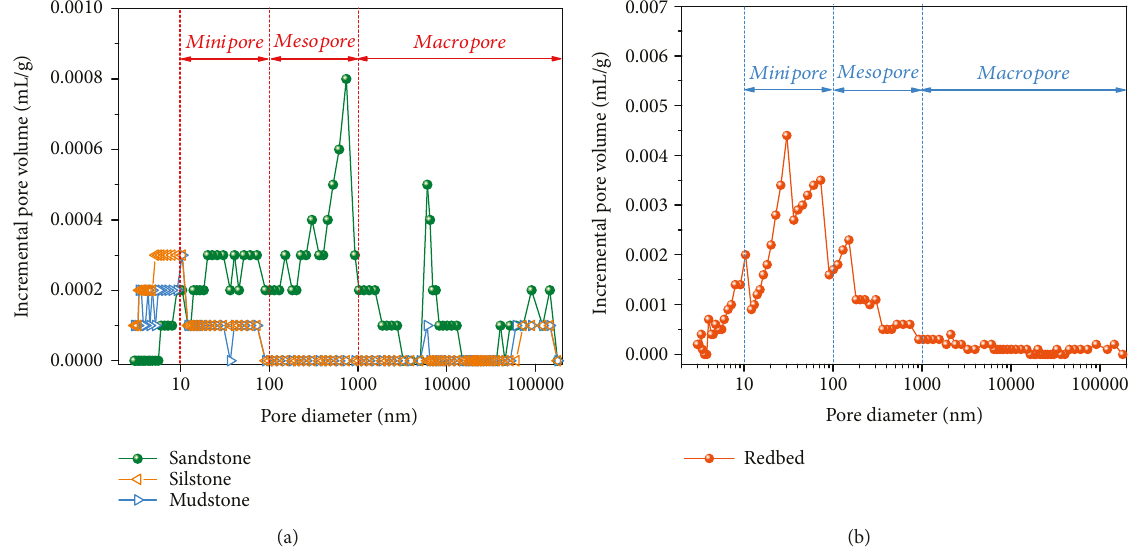
Figure 7: Pore size distributions of cap rock samples from the MIP method. (a) Sandstone, siltstone, and mudstone; (b) Redbed. Note: each rock sample is obtained from the coal-bearing strata and Redbed in the surface drilling hole of